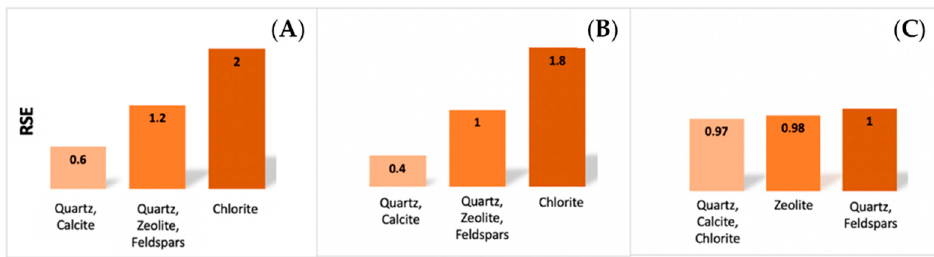
Figure 7. Relative sorption efficiency values of cesium ( A ), strontium ( B ) and americium ( C ) on mineral phases of R-11 sample.